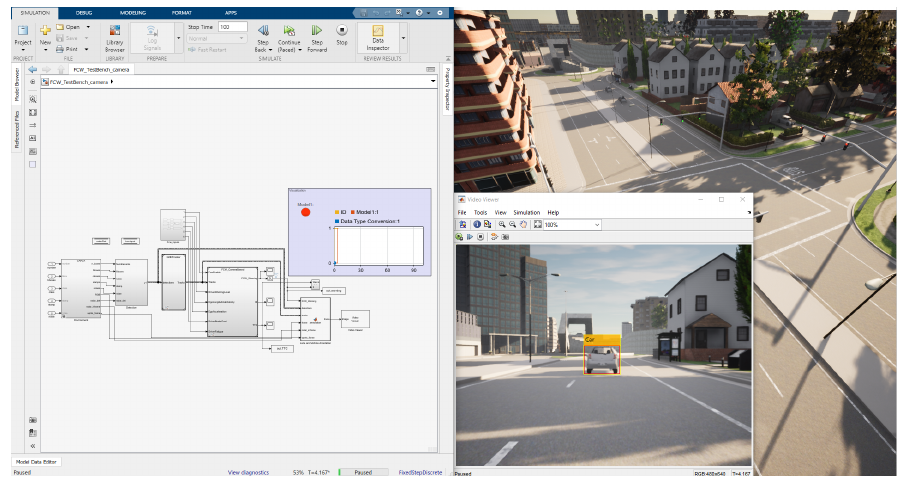
Figure 2. Screenshot of the co-simulation platform. On the right the CARLA server; on the left the Simulink implementation of the proposed algorithm supported by the communication APIs between the two